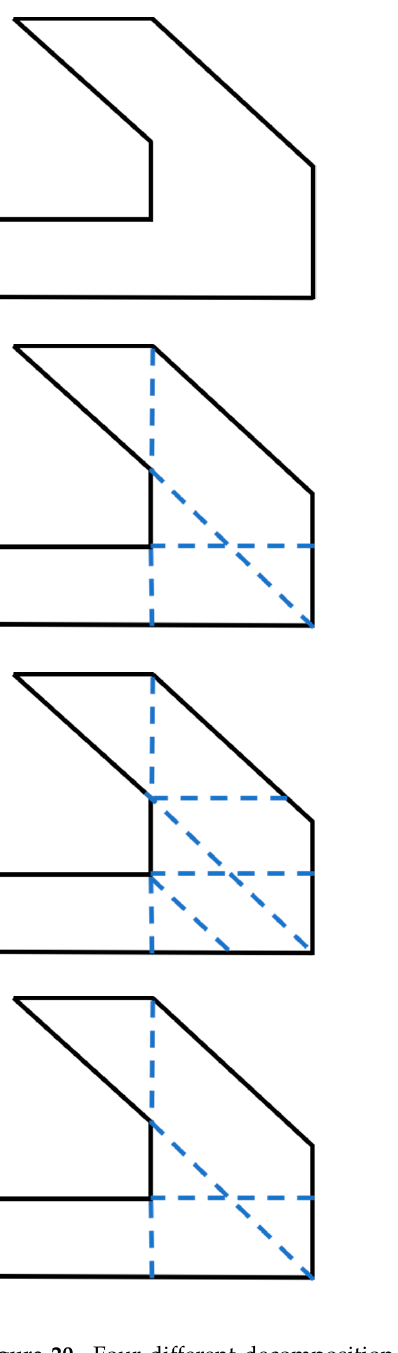
Figure 20. Four different decomposition methods. ( a ) Line sweep decomposition methods; ( b ) MSA decomposition method; ( c ) enhanced exact cellular decomposition method; ( d ) improved DFS method.